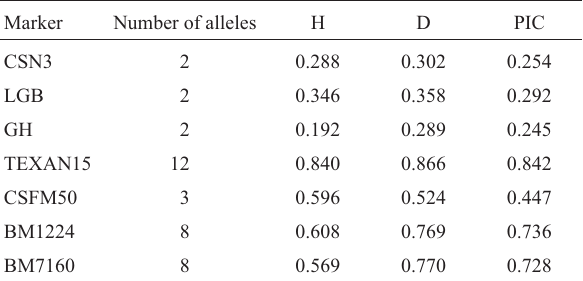
Table 3 - Genetic diversity (D), heterozygosity (H) and polymorphic information content (PIC) estimates for Aberdeen Angus cattle. Marker Number of alleles